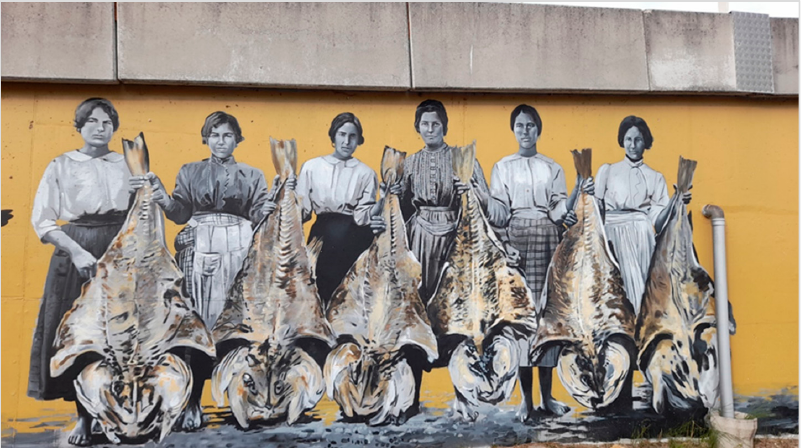
Figure 3. Women and the cod drying process, by urban artist António Conceição, 2020 (Source: author’s own photo, 2022).